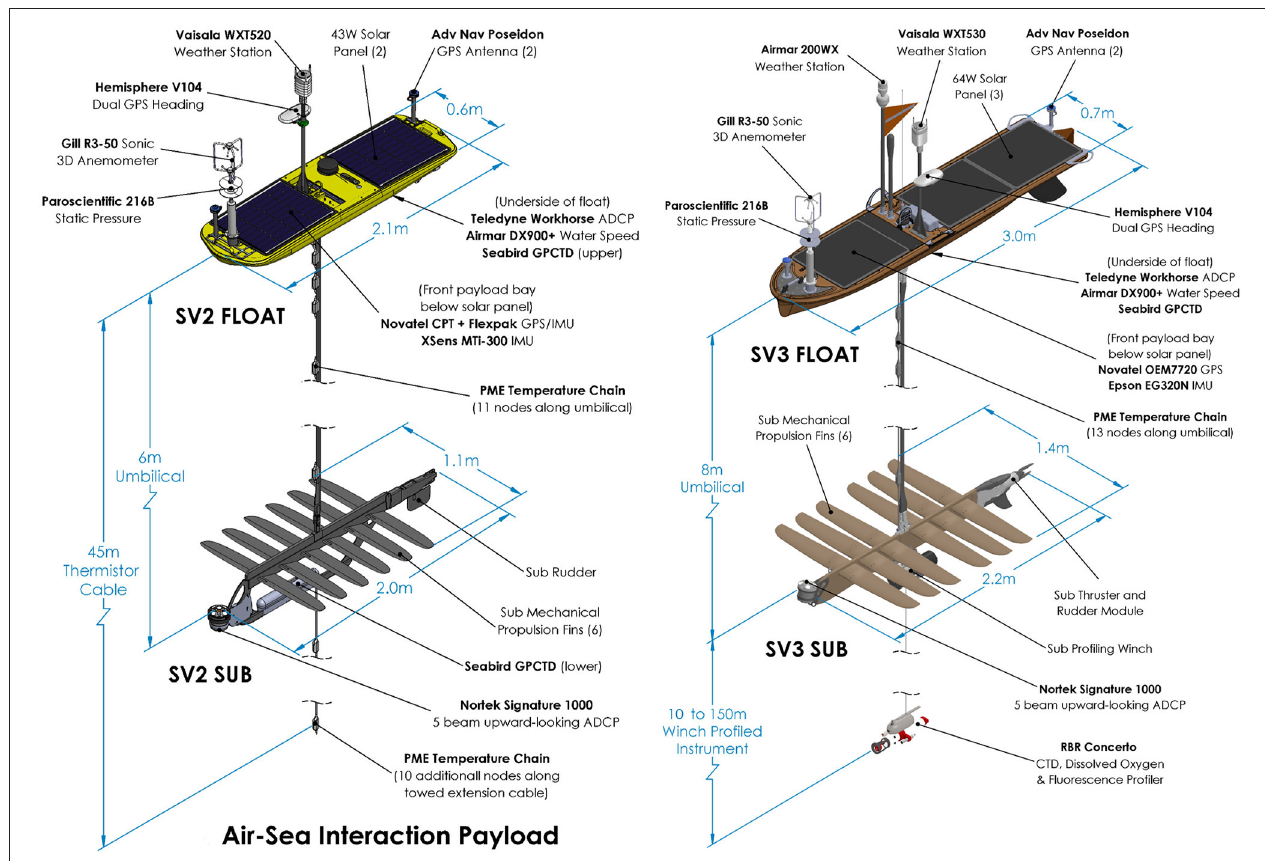
FIGURE 1 | Perspective views of the Air-Sea Interaction Laboratory SV2 and SV3 Wave Gliders showing their respective instrument packages and their most relevant